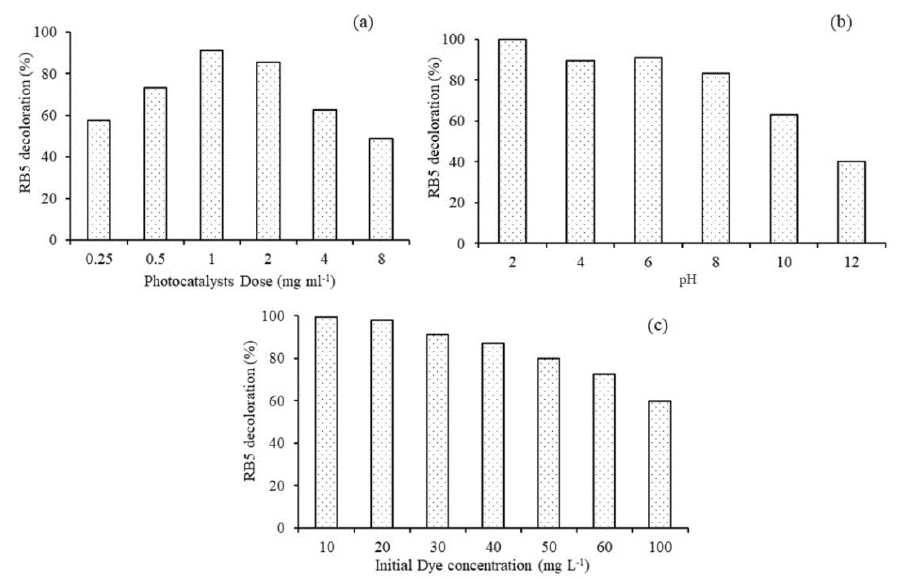
Figure 8. Effect of ( a ) photocatalyst dose; ( b ) pH; ( c ) initial dye concentration on the percent decolorization of RB5 azo dye using 0.1Fe-TiO 2 -300 °C.